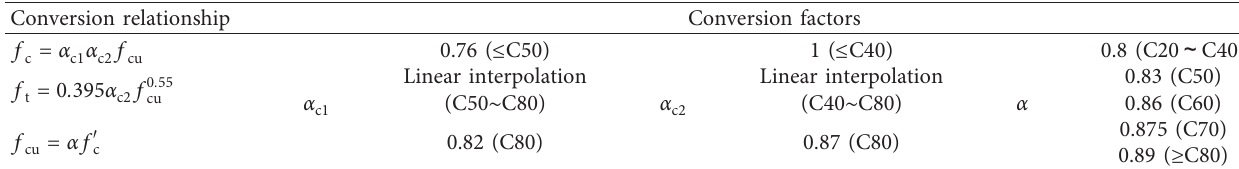
f ′ , f c , t , and f cu c